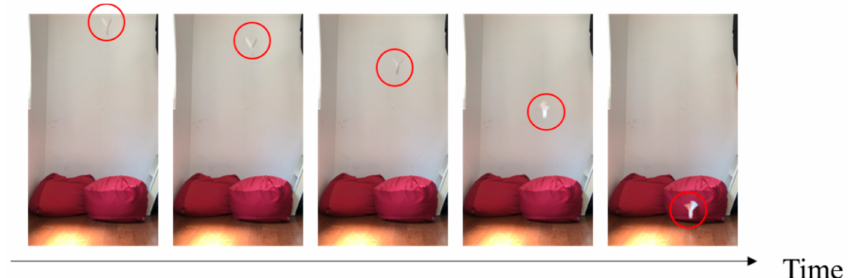
Figure 3. Falling test of the model of the